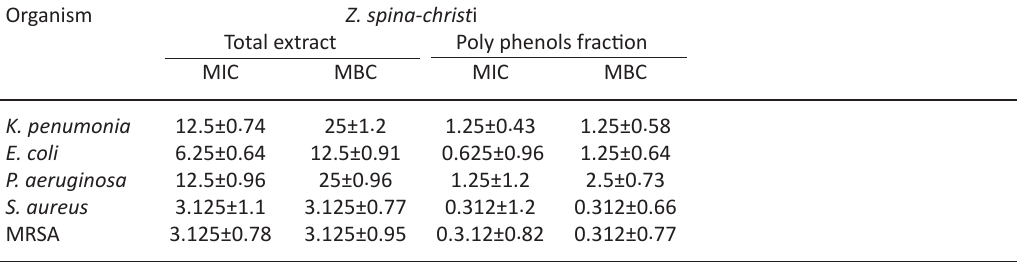
Table 3. MIC and MBC of Z. spina-christi total extract and its polyphenol fraction